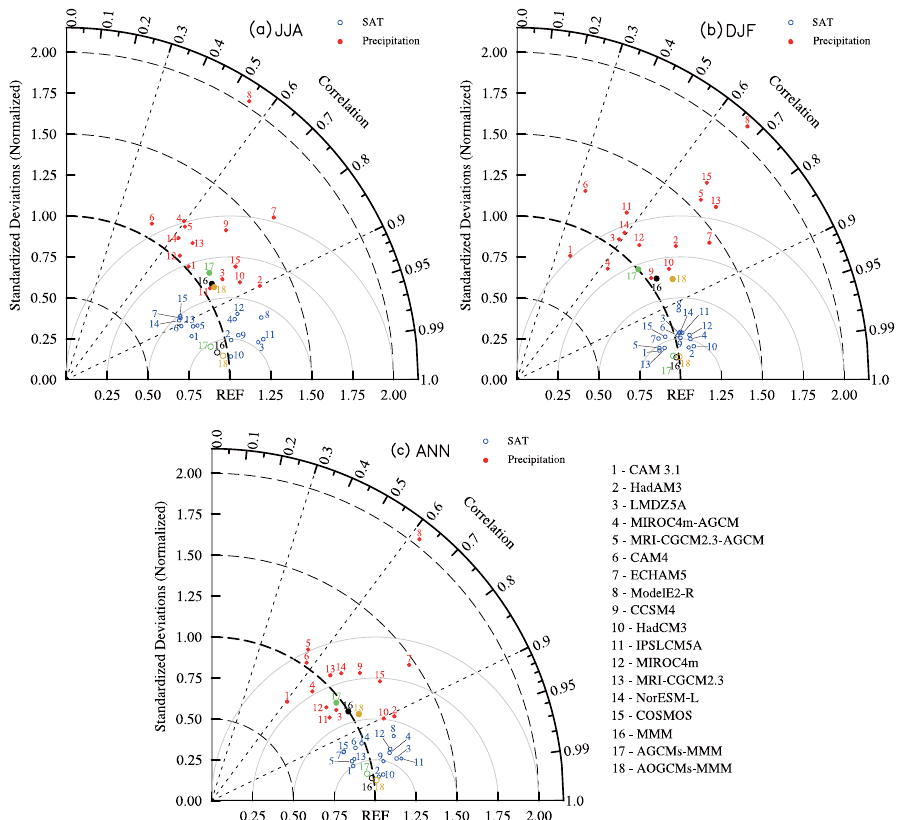
Fig. 3. Taylor diagrams of (a) summer, (b) winter and (c) annual mean SAT and precipitation in China for different models. The point REF indicates the ERA40 reanalysis data averaged within 1972–2001 (Uppala et al., 2005) for SAT, and the CMAP data averaged within 1979–2008 (Xie and Arkin, 1996) for